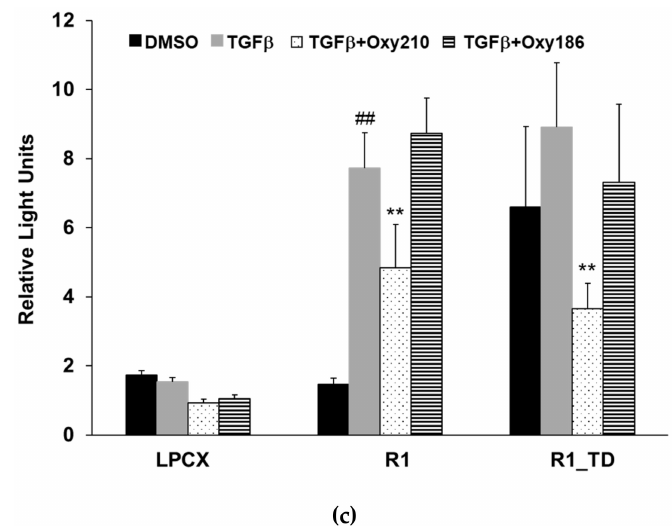
Figure 11. Inhibition of TGF β -induced Smad2 / 3 phosphorylation and transcriptional activity. ( a ) Western blot analysis of A549 cells. Cells were pretreated with DMSO, Oxy186 or Oxy210 for 3 h, then treated with TGF β (4 ng / mL) for the indicated times. ( b ) Kinase assay was performed as described in Materials and Methods with the agents as indicated. ( c ) TGF β RI-deficient R1BL17 cells were transfected with TGF β RI plasmid (WT or TD mutant), Smad responsive luciferase reporter (CAGA12-Luc), and pTK-Renilla-Luciferase plasmid. Twenty-four hours after transfection, cells were treated with the test agents as indicated for 20 hrs. Luciferase activity was measured and normalized to the Renilla luciferase activity. Data from a representative experiment are reported as the mean of triplicate determinations ± SD (** p < 0.01 vs. TGF β treated cells; ## p < 0.01 vs. DMSO; ++ p < 0.01 vs.